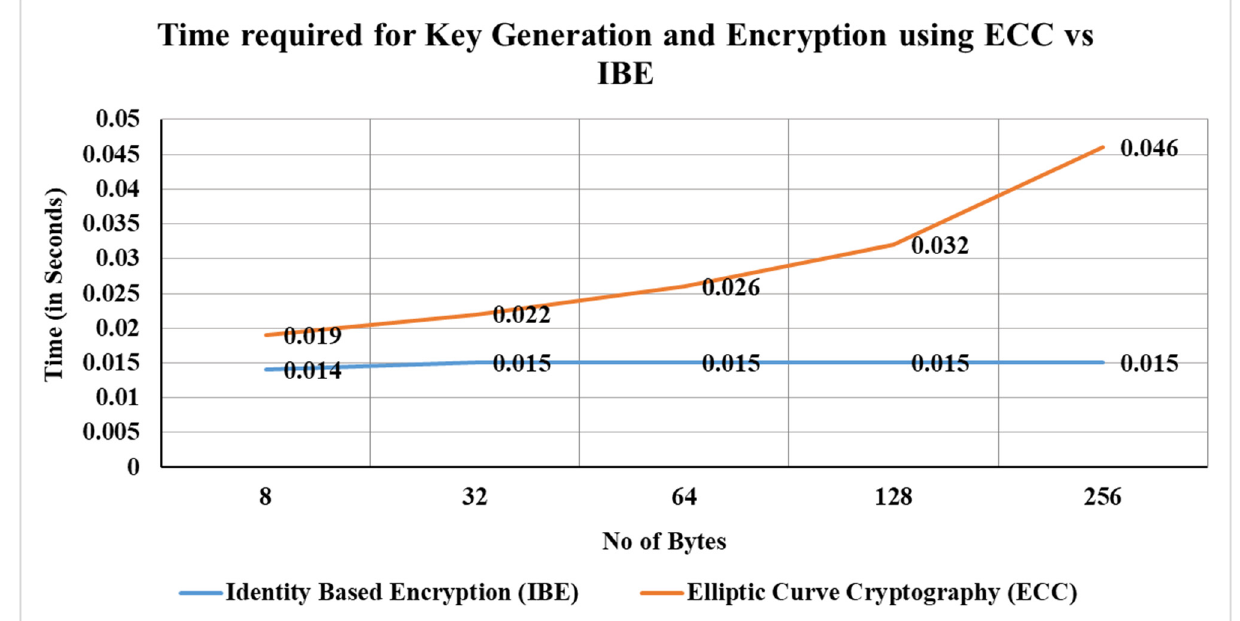
Figure 14. Comparison between times required for the key generation and encryption using ECC and IBE.